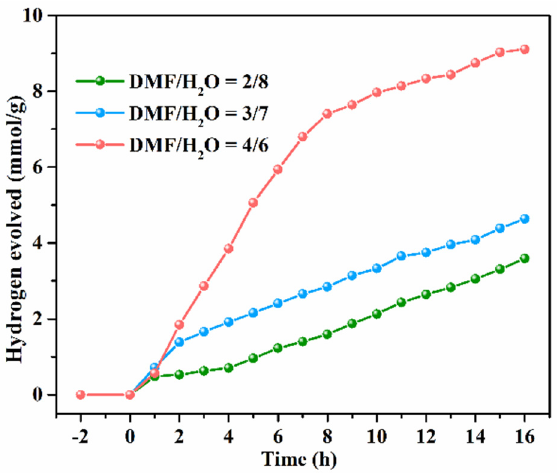
Figure 7. The rate of hydrogen photogenerated over catalyst 1 (80 mg) in different solvent ratio (Total volume: 100 mL, pH = 11.5) containing Na 2 S and Na 2 SO 3 under visible light irradiation.